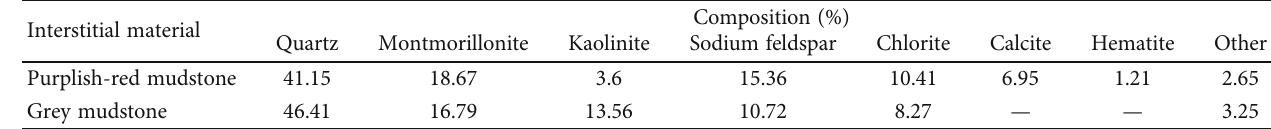
Table 1: Mineral composition of interstitial materials.